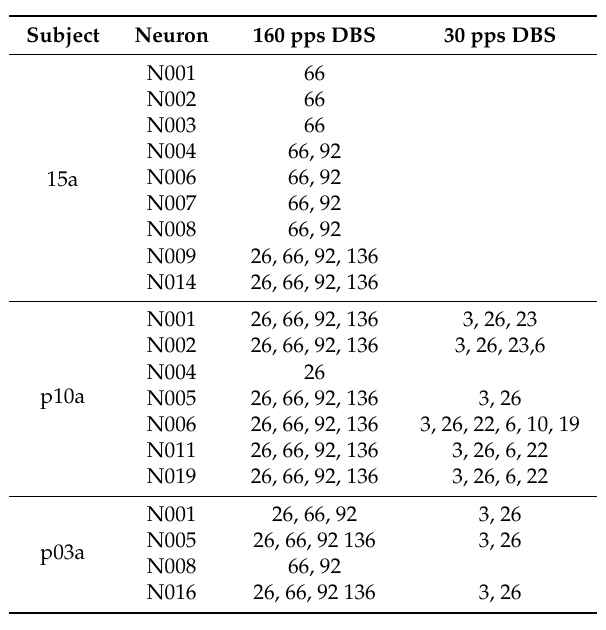
Table 1. Results of power spectral densities on antidromic-only-spike trains. Frequencies associated with the peaks are reported (in Hz).